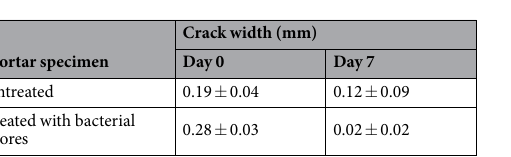
Table 2. Crack width measurement. Data are shown as the mean ± SE, derived from three replications.